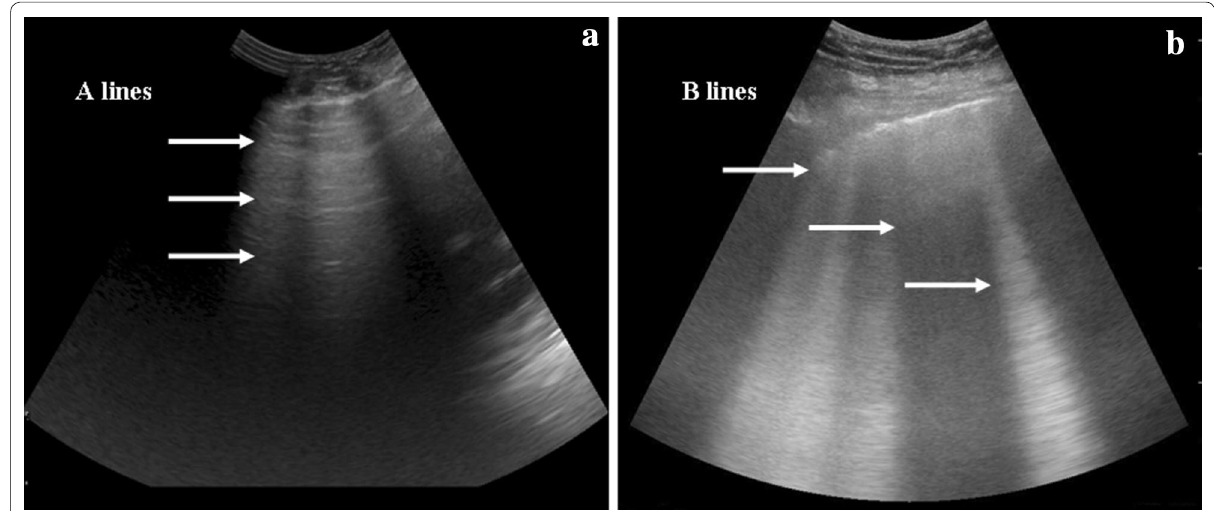
Fig. 3 a A profile—dry lung; b B profile—wet